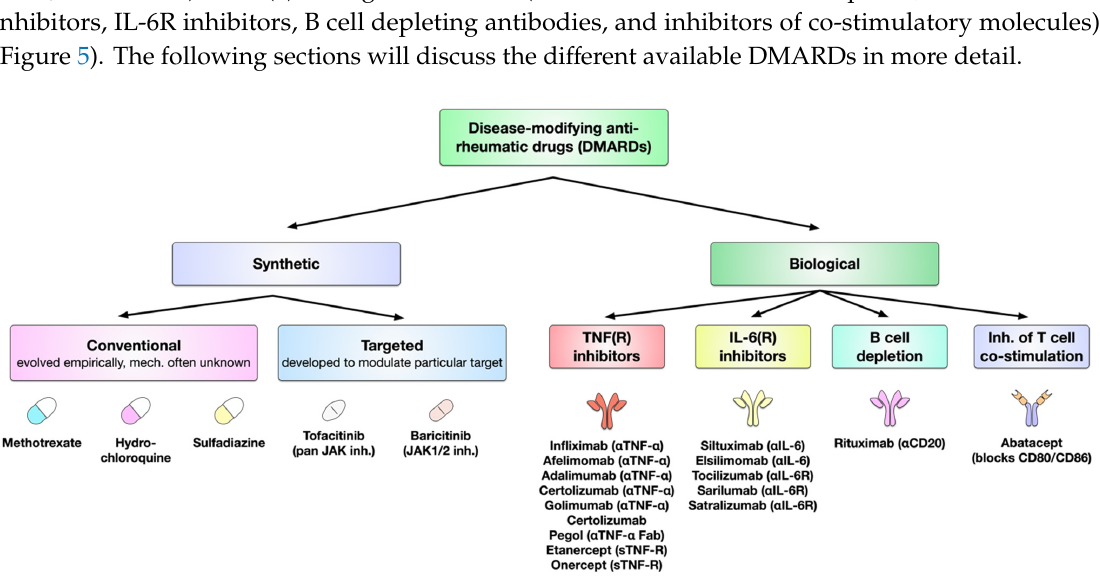
Figure 5. Overview over the currently available DMARDs. The different DMARDs are grouped into synthetic (further subdivided into conventional and targeted synthetic DMARDs) and biological DMARDs. Biological, antibody-based, DMARDs include anti-TNF- α and anti-TNF-R antibodies, anti-IL-6- and anti-IL-6R antibodies, B cell depleting anti-CD20 antibodies, as well as inhibitors